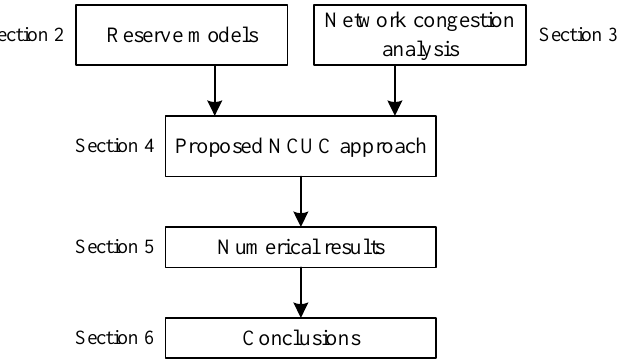
Figure 1. Organization chart of other part of this paper.